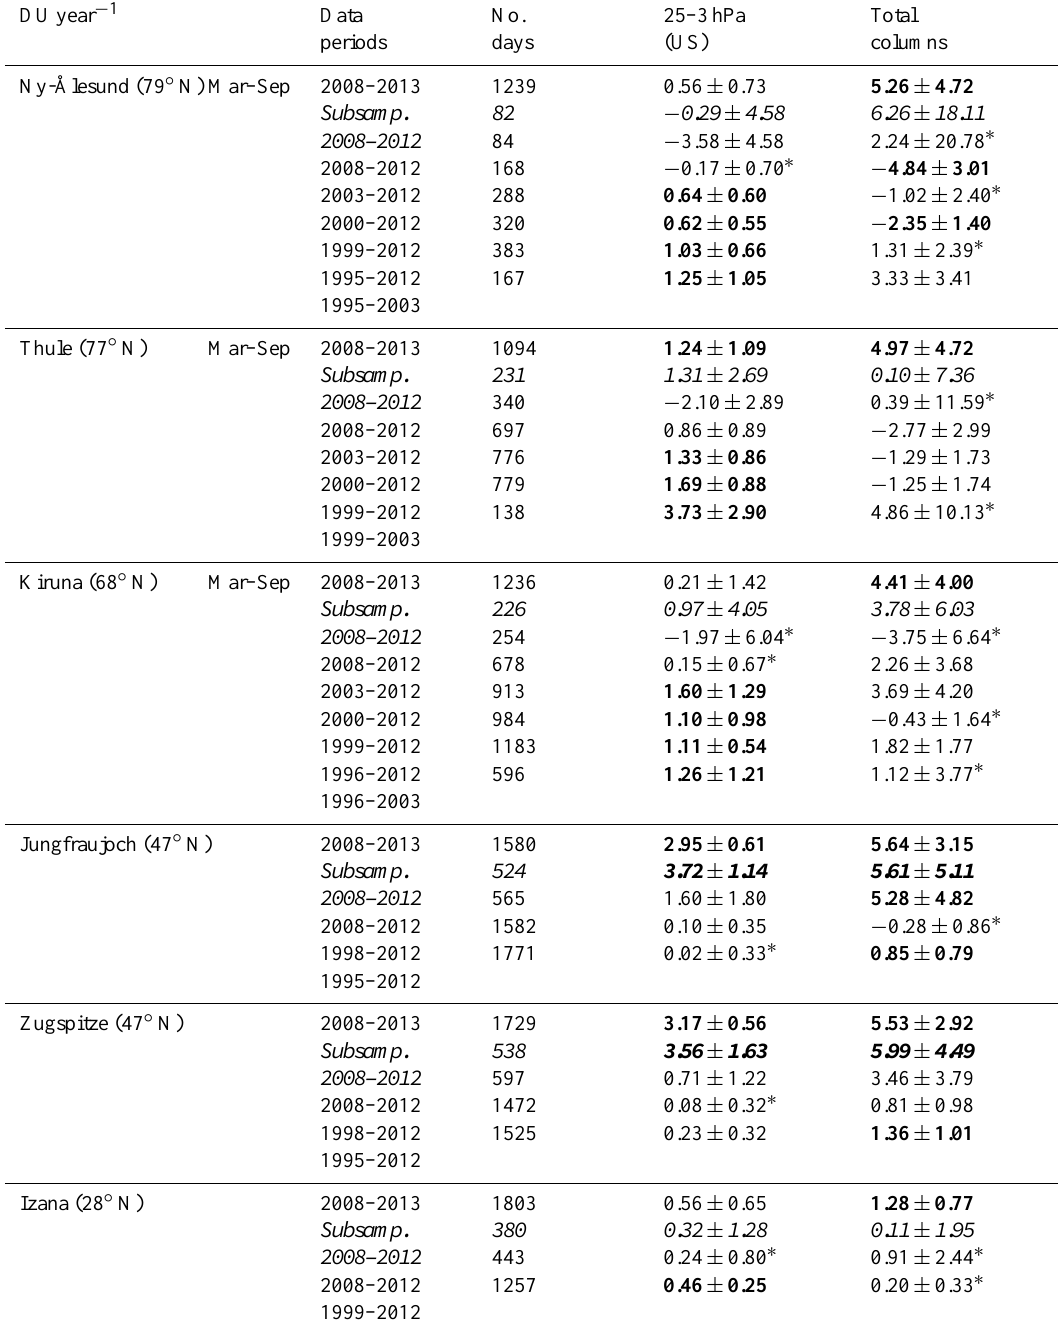
a The trend values result from the adjustment of the regression model where the linear term is kept whatever its p value calculated during the iterative process